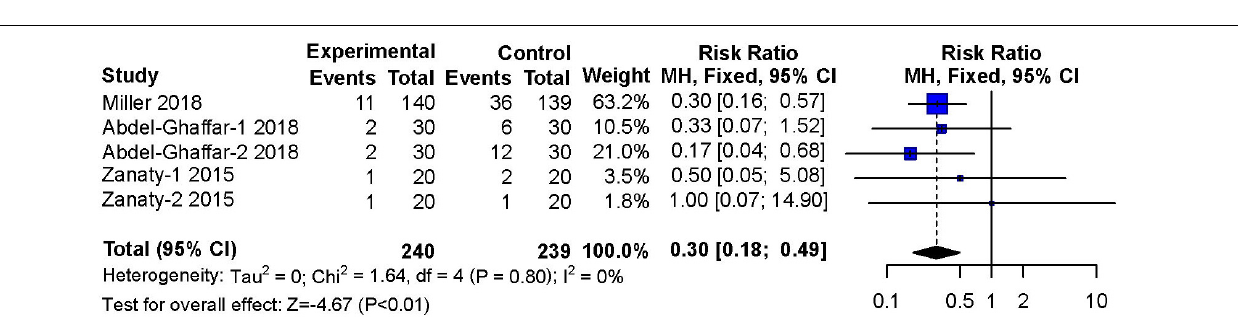
FIGURE 7 | Meta-analysis of nebulized dexmedetomidine for satisfactory mask acceptance. CI, confidence interval; df, degress of freedom; M-H, Mantel-Haenszel.